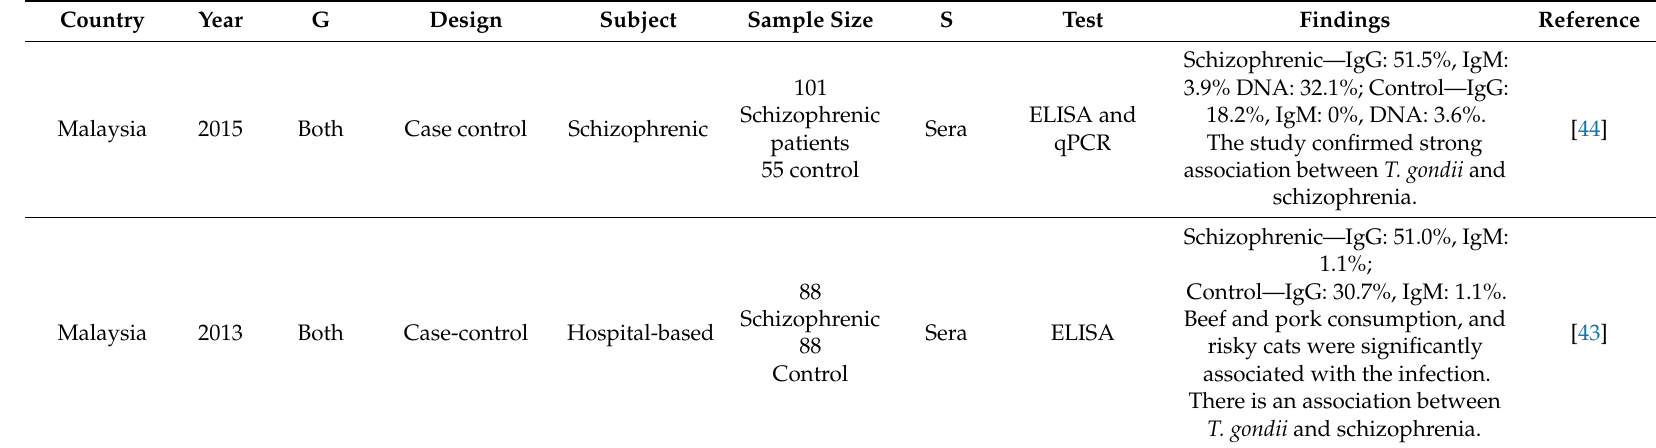
Table 6. Serological prevalence of toxoplasmosis among schizophrenics in